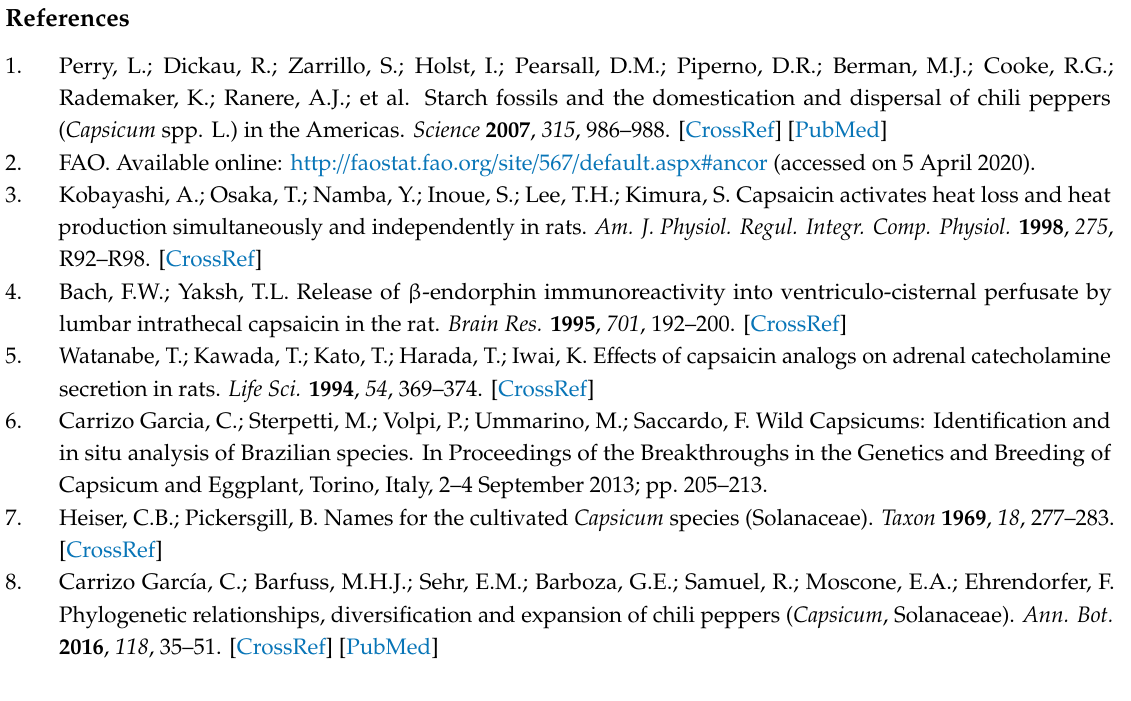
Figure S1: Molecular phylogenetic tree based on a maximum-likelihood analysis of rDNA-ITS sequences with evolutionary distances, Table S1: Morphological traits of Capsicum investigated in the present study, Table S2: Length range (bp) and GC content (%) analysis of ITS